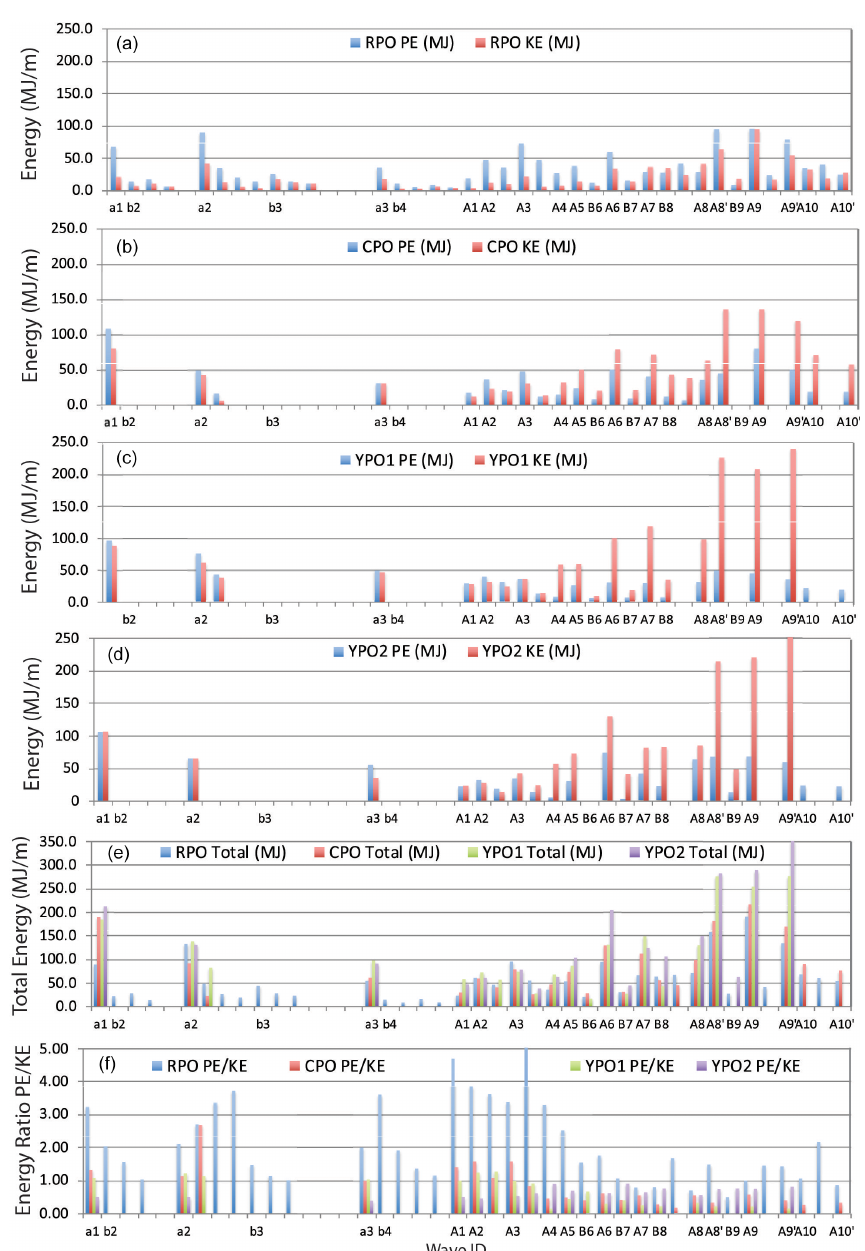
Figure 15. Energy transformations across the slope. The total HKE and APE, computed by integrating the wave energy both vertically and horizontally at moorings RPO, CPO, YPO1, and YPO2, are shown in (a) – (d) respectively. The total pseudo-energy (HKE + APE) at all four moorings is shown for each wave in (e) and the APE / HKE ratio in (f)